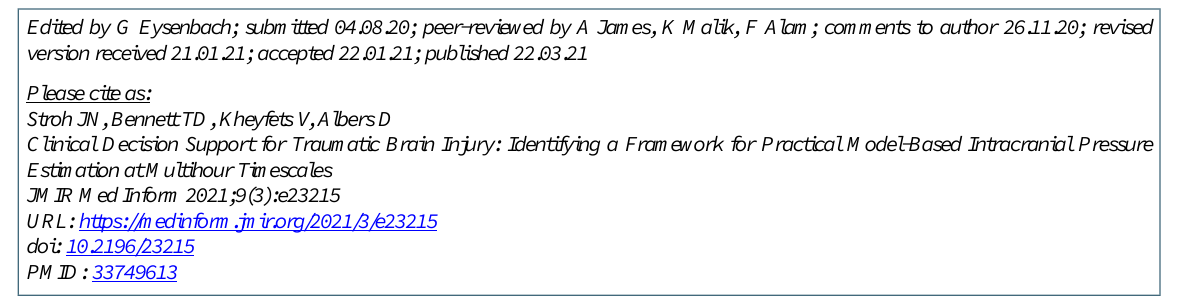
Clinical Decision Support for Traumatic Brain Injury: Identifying a Framework for Practical Model-Based Intracranial Pressure Estimation at Multihour